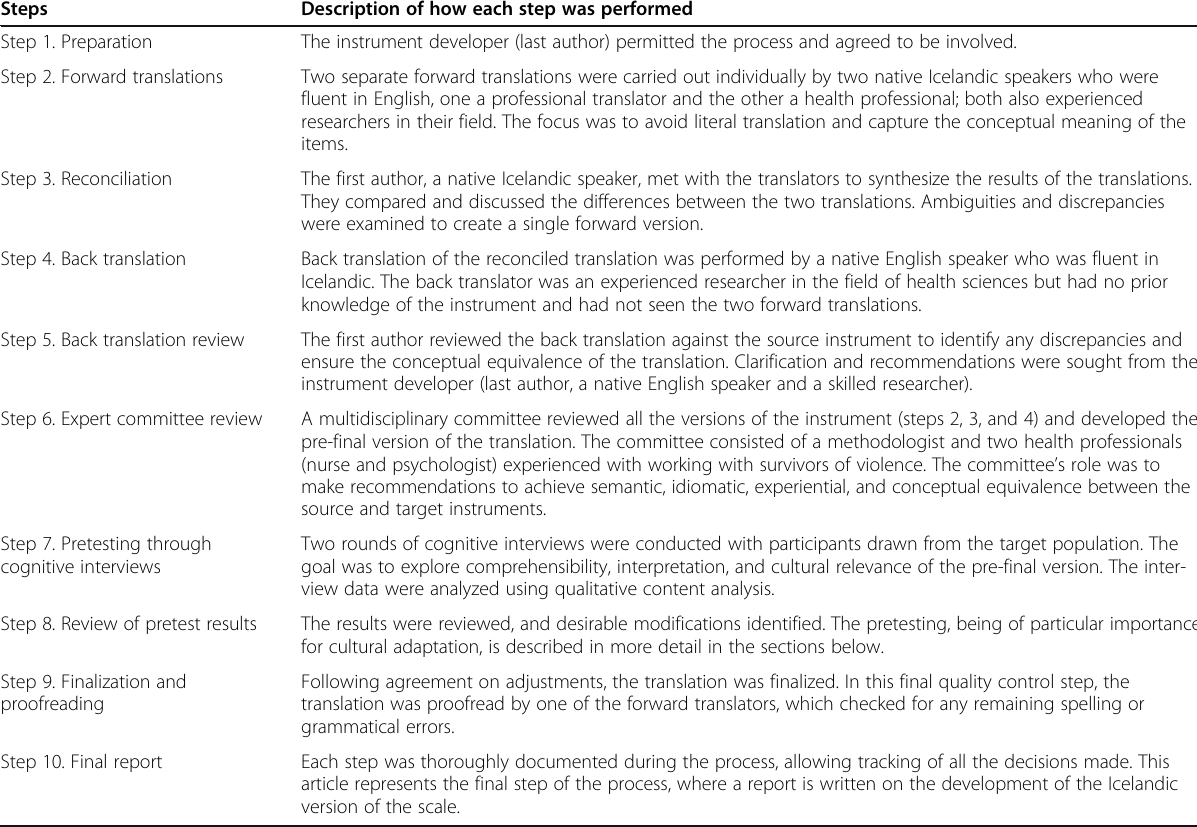
Table 1 Overview of the cross-cultural adaptation process, based on [27,